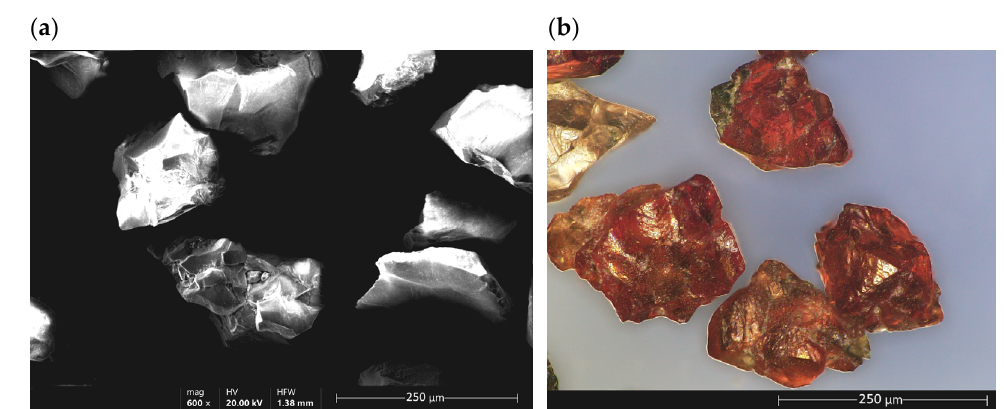
Figure 9. Control factors at optimal levels for each output factor.